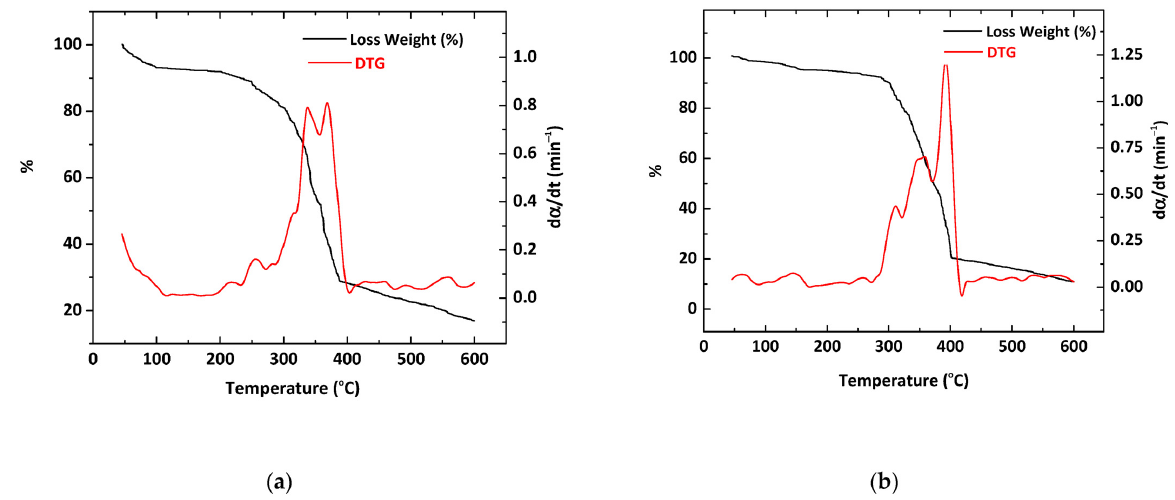
Figure 2. Thermogravimetric curves (TGA) and their derivatives (DTG) for ( a ) Microcystis LTPNA 01 and ( b ) a bloom sample from 50 to 600 °C.